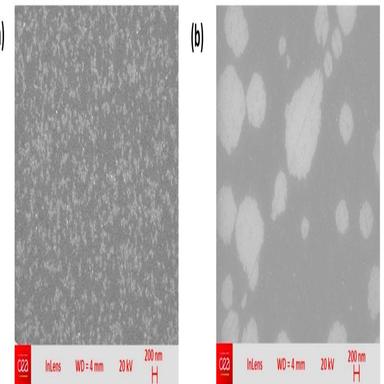
FE-SEM observations of domains after BEN on (a) Ir/STO/Si (001); (b) Ir/STO (001).